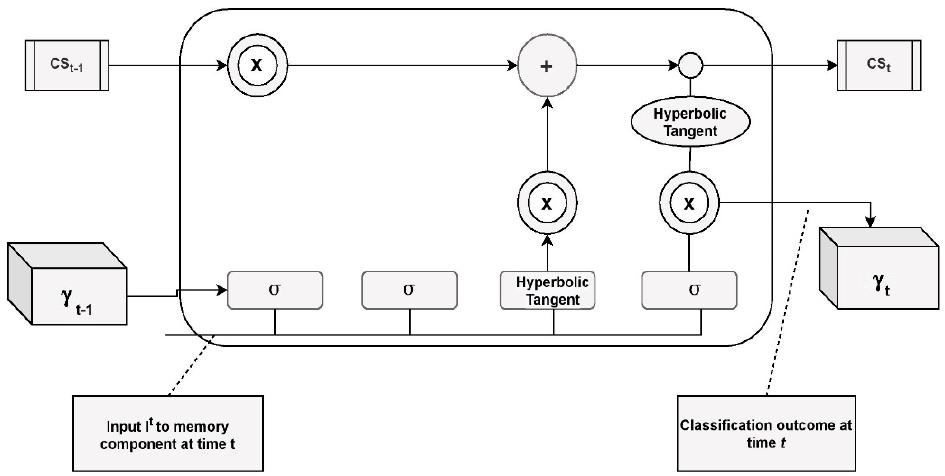
Figure 2. Architecture of LSTM component.